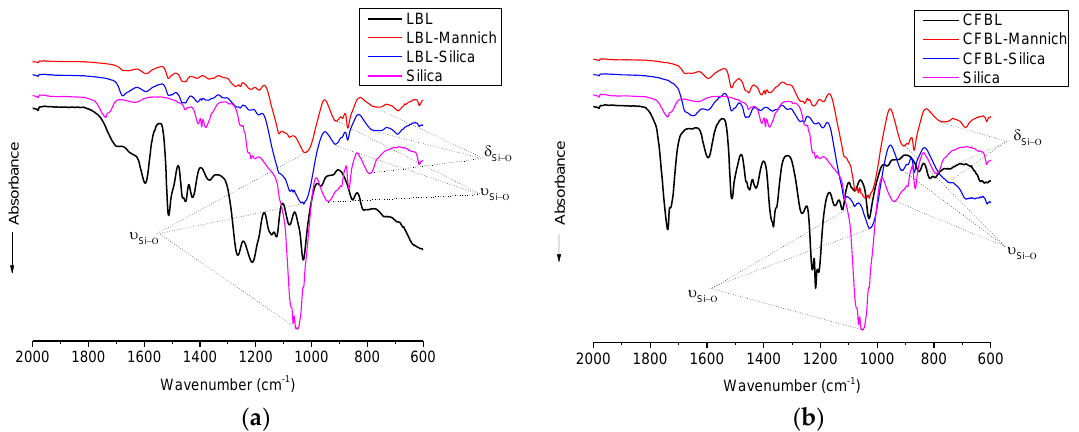
Figure 4. Fourier transform infrared (FTIR) spectra of the materials based on ( a ) LBL and ( b ) CFBL: initial lignin; lignin modified by the Mannich reaction; lignin-silica hybrids and synthesized pure silica.